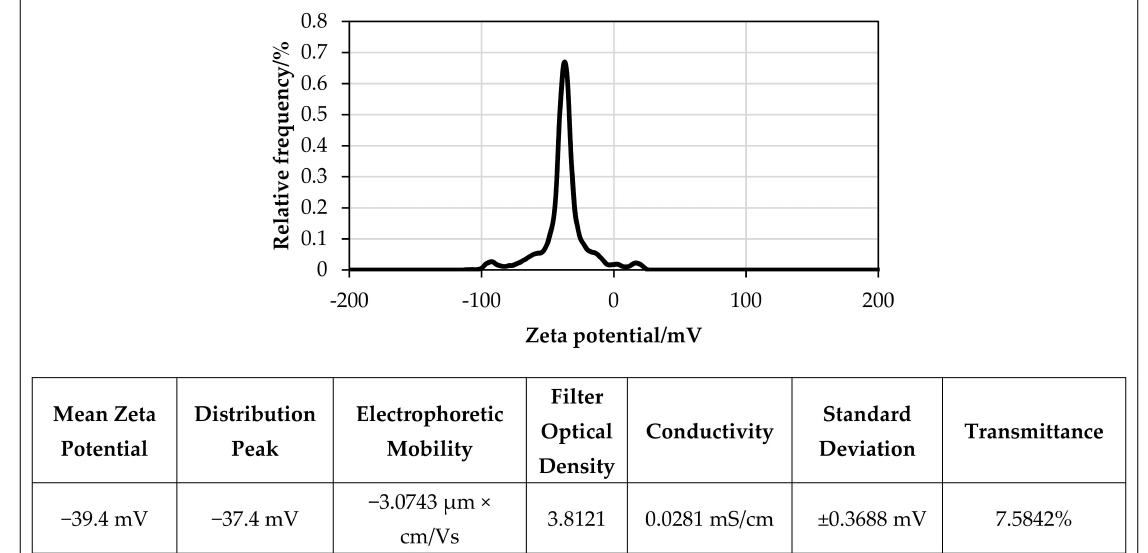
Figure 6. Zeta potential distribution of f-GNPs nanofluids at 25 ◦